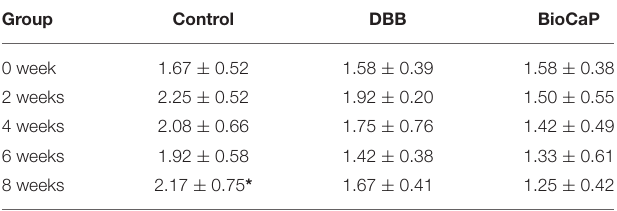
TABLE 1 | Periodontal probing depth (mm) of orthodontic